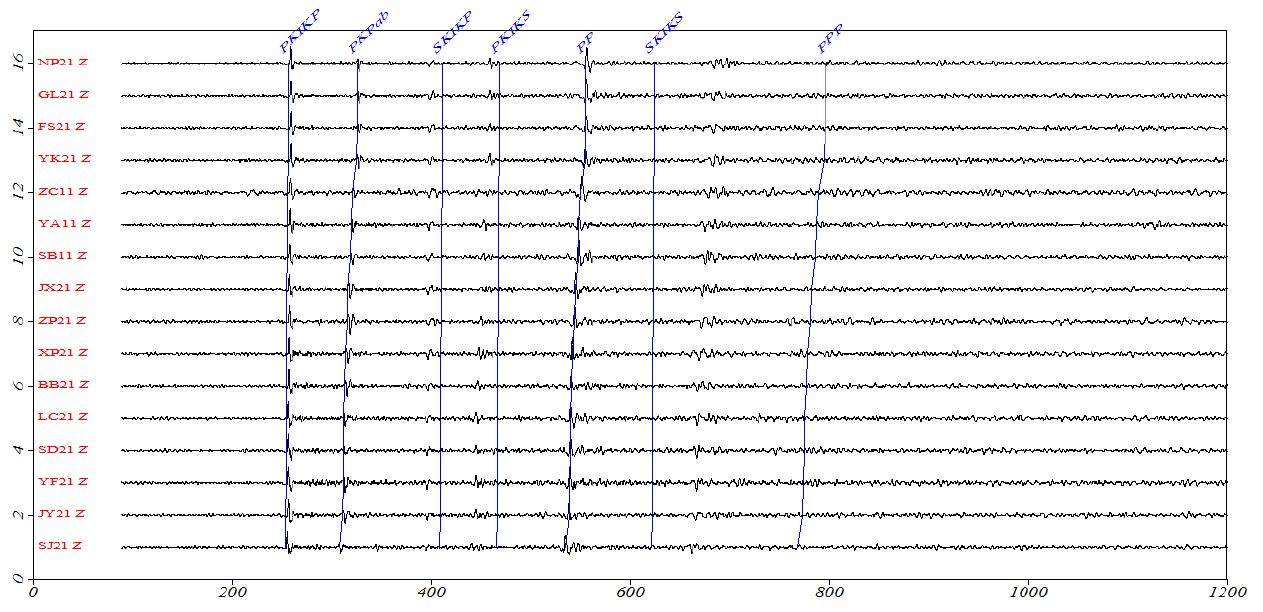
Figure 5. Theoretical arrival times of seismic records and P and S phases in the Alo Islands.